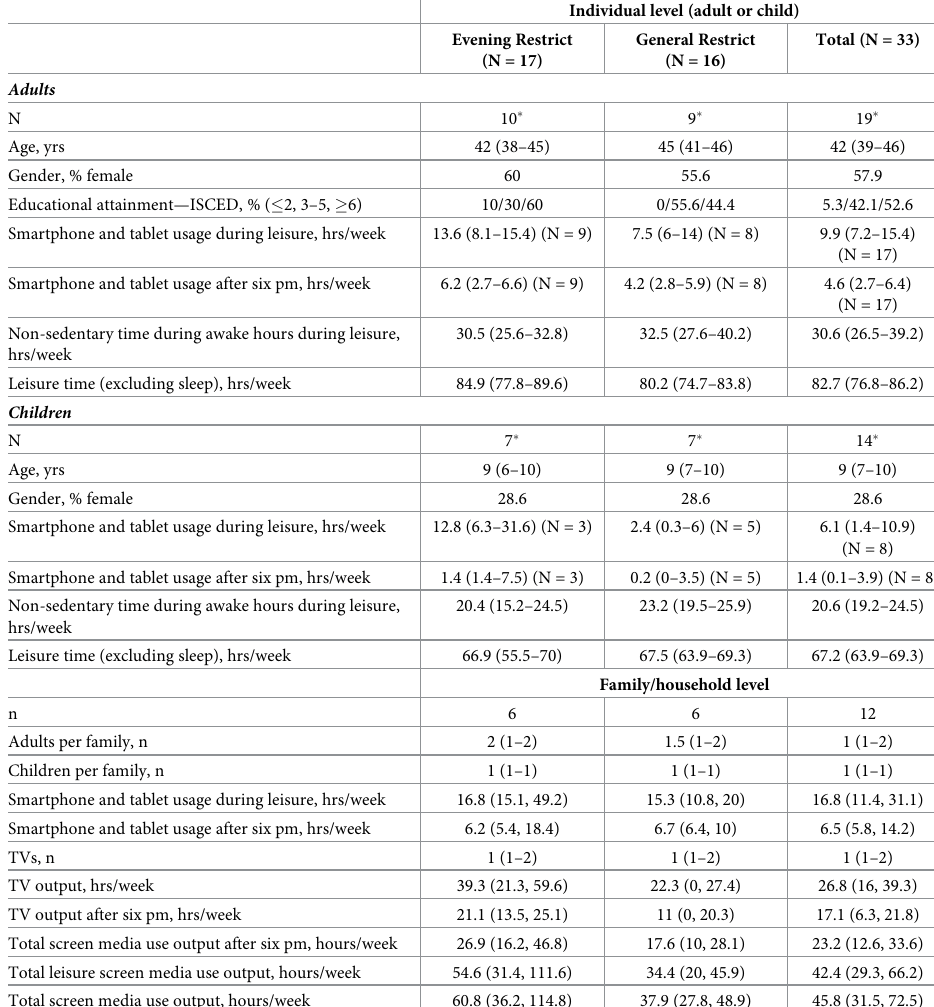
Table 1. Baseline characteristics of sample and screen media use during baseline (one